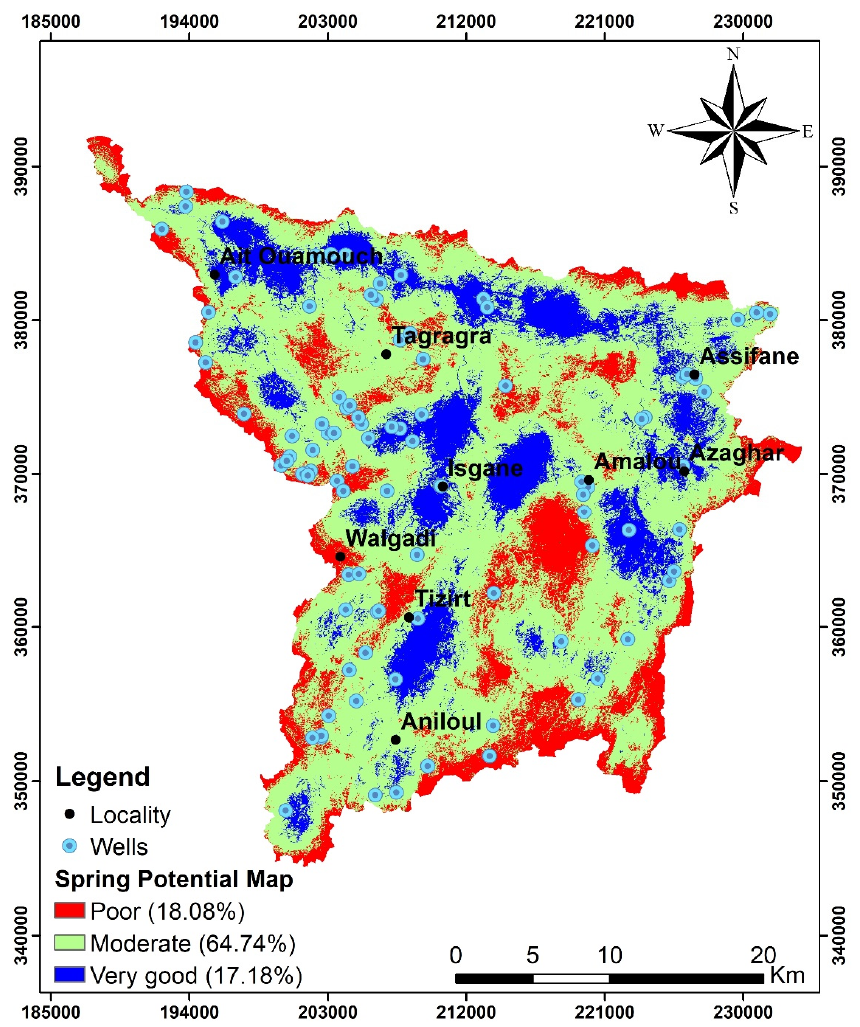
Figure 7. Groundwater potential map produced by AHP model.